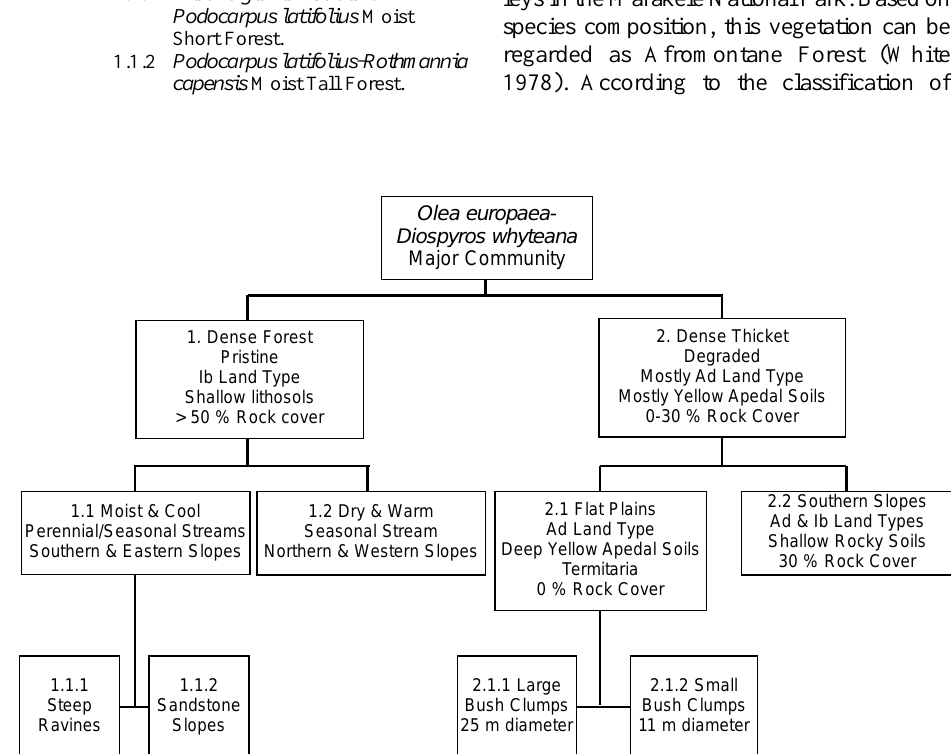
Fig. 1. A dendrogram showing the habitat relationships of the plant communities classified under the Olea europaea- subsp. africana-Diospyros whyteana Major Community.